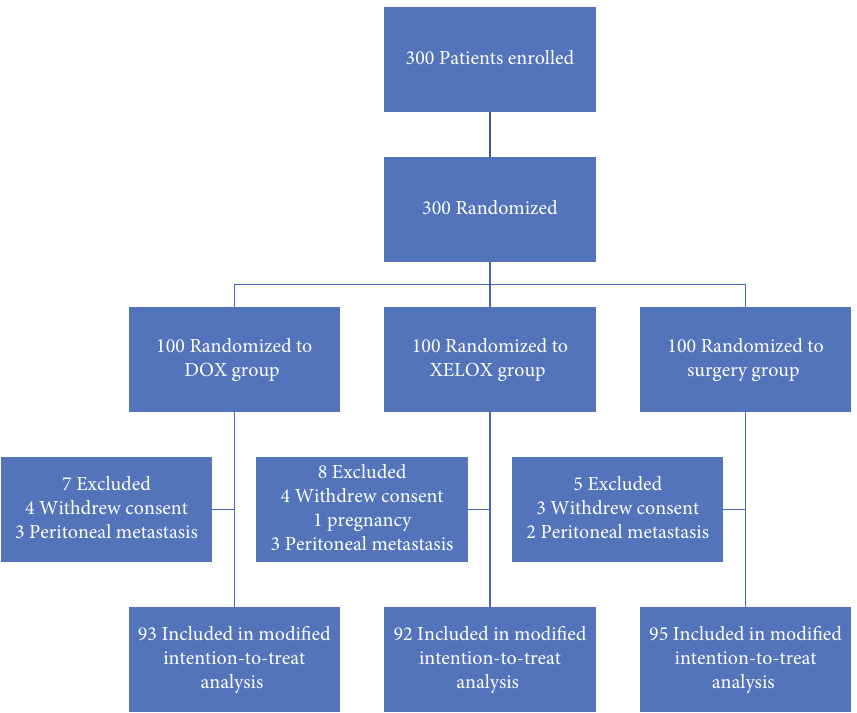
Figure 1: Trial pro fi le. DOX =capecitabine, oxaliplatin, and docetaxel; XELOX=capecitabine and